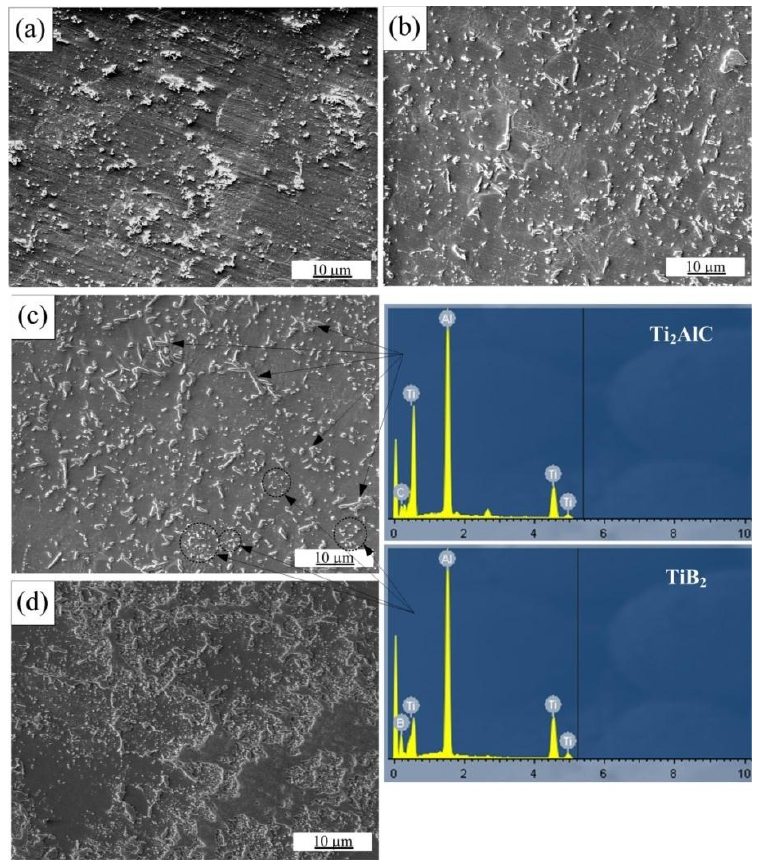
Figure 2. Microstructures of ( a ) 2 vol. % TiB 2 -Ti 2 AlC/TiAl; ( b ) 4 vol. % TiB 2 -Ti 2 AlC/TiAl; ( c ) 6 vol. % TiB 2 -Ti 2 AlC/TiAl and ( d ) 8 vol. % TiB 2 -Ti 2 AlC/TiAl composites